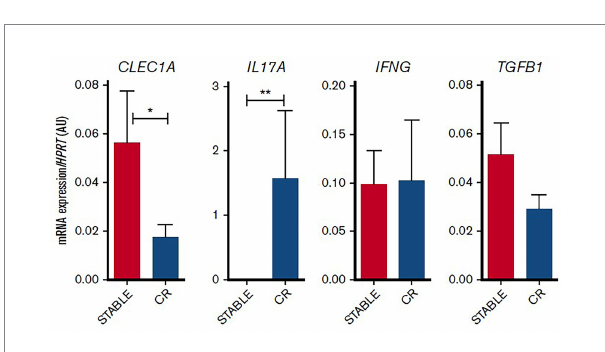
FIGURE 7 Decreased CLEC1A expression in lung transplants is predictive of CLAD. Lung transplants from stable patients or from patients prior to the development of CLAD were subjected to qRT-PCR for HPRT, CLEC1A, IL17A, IFNG, and TGFB1. Results were expressed in histograms as mean 6SEM of 7 samples in each group and were expressed in AU of specific cytokine/HPRT ratio. * p , 0.05; ** p , 0.01. mRNA, messenger RNA, adapted from